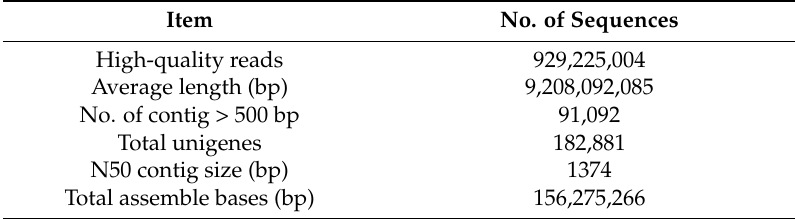
Table 1. Summary of the transcriptome data and the assembly results for ginseng main root tissues.